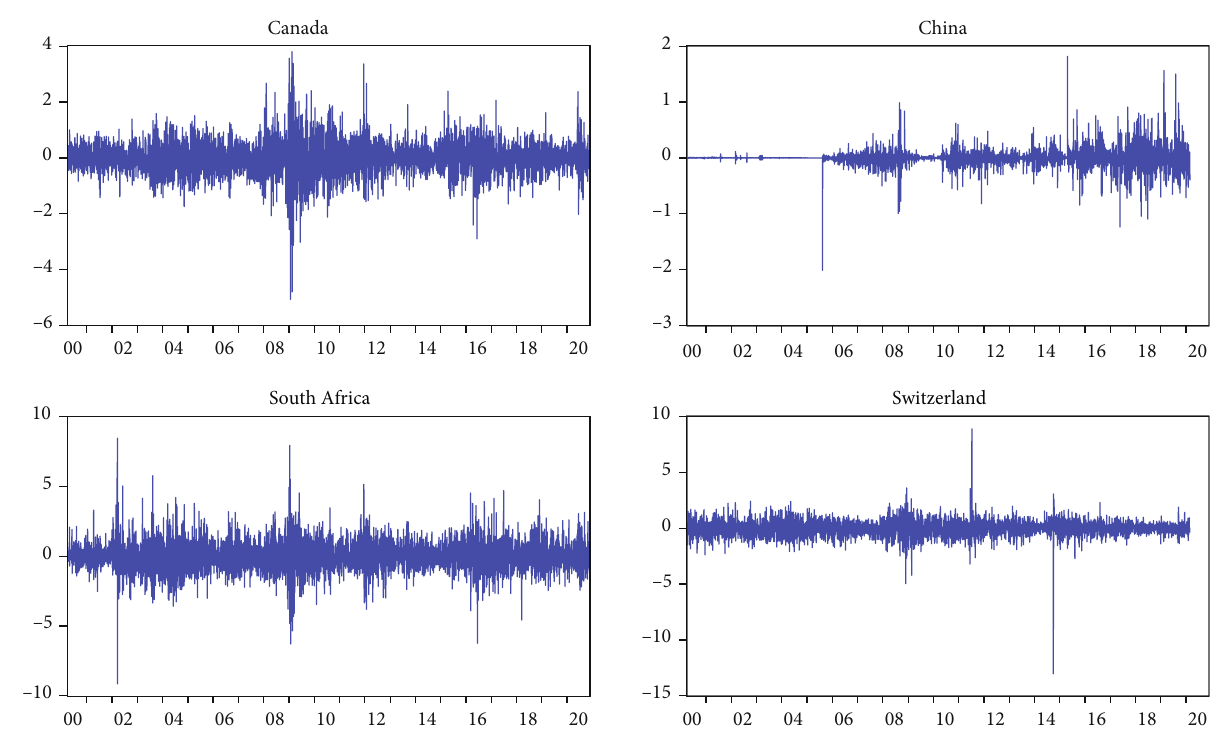
Figure 3: Time series plot of growth rates by country. Source: FRED,